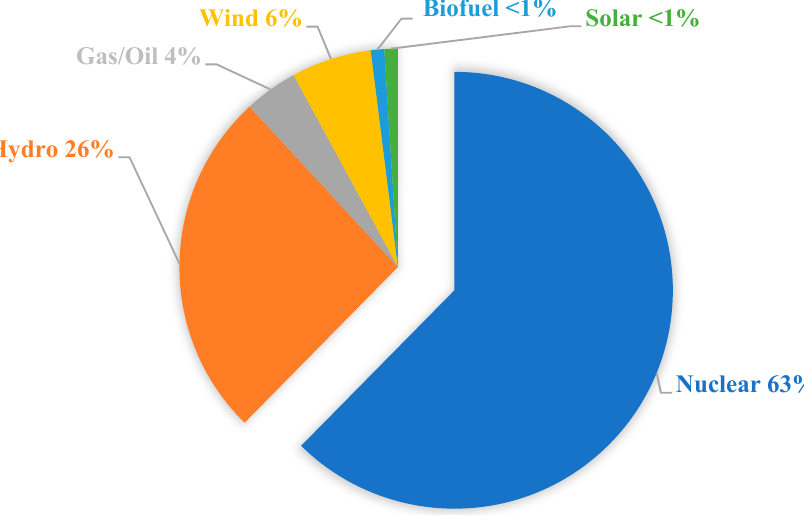
Figure 1. Ontario electricity supply mix in 2017 [14].